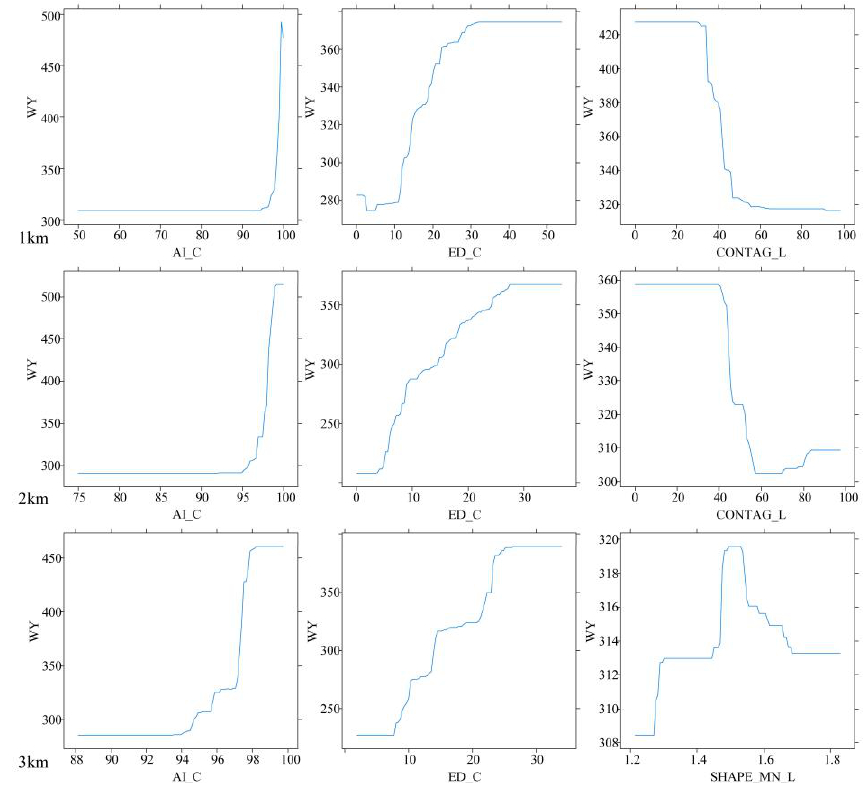
Figure 8. The partial dependence plots of WY on the three most important landscape metrics at different spatial scales.